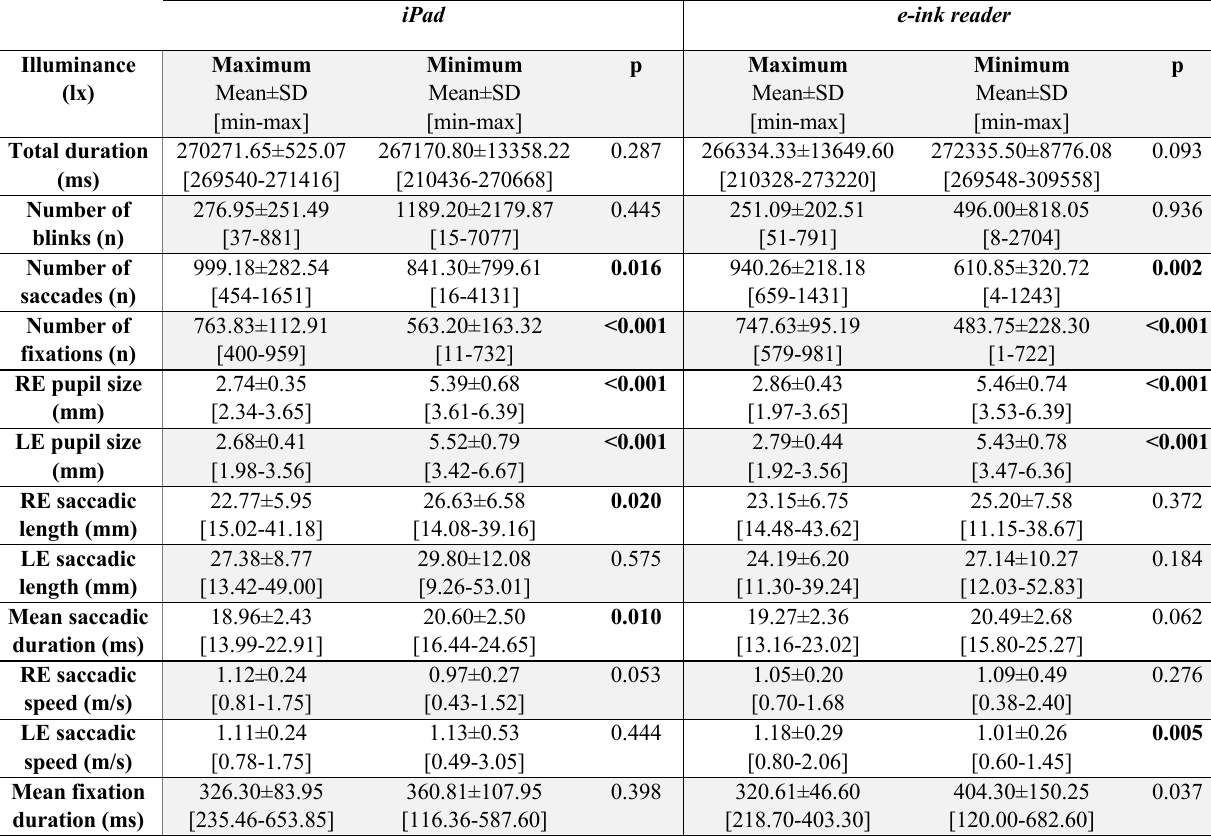
Table 1. Descriptive data and comparison of different environmental lighting conditions with the same device between the num- ber of blinks, saccades and fixations, Right Eye (RE) and Left Eye (LE) pupillary diameters, length and velocity of the saccade in the RE and LE, and mean duration of saccades and fixations. Mean value±standard deviation (SD); minimum and maximum measured values, the differences are considered statistically significant (marked in bold) when a p-value <0.025